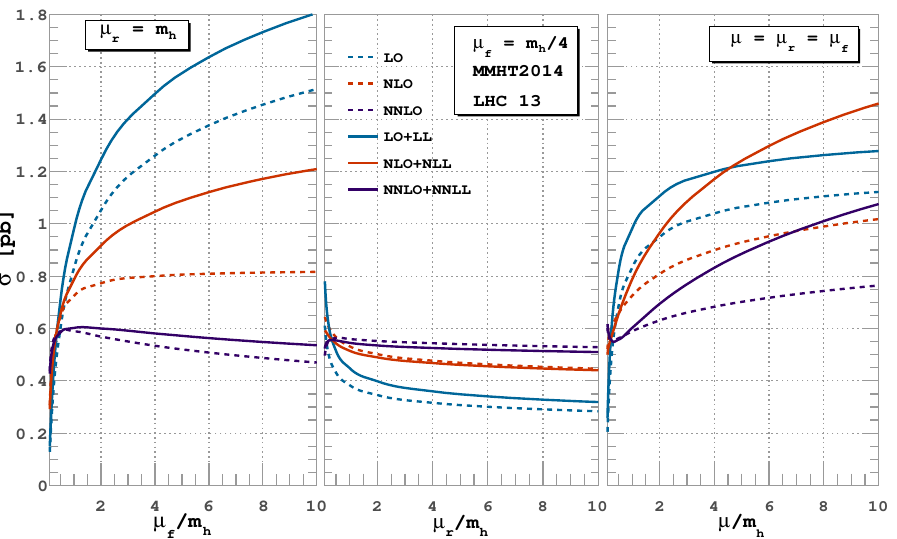
Figure 2 . Fixed order and resummed cross-sections are plotted successively at each order up to NNLO level with unphysical factorization ( (cid:22) f ) scale varied in the range (1 = 10 ; 10) m h keeping renormalization scale ( (cid:22) r ) (cid:12)xed at central value m h . Similar variation for (cid:22) r is done in the second panel keeping (cid:22) f = m h = 4. In the last panel, the (cid:22) r is set to (cid:22) f and is varied in the same range. de(cid:12)ned as the ratio of the cross-section at a particular order (NLO+NLL,